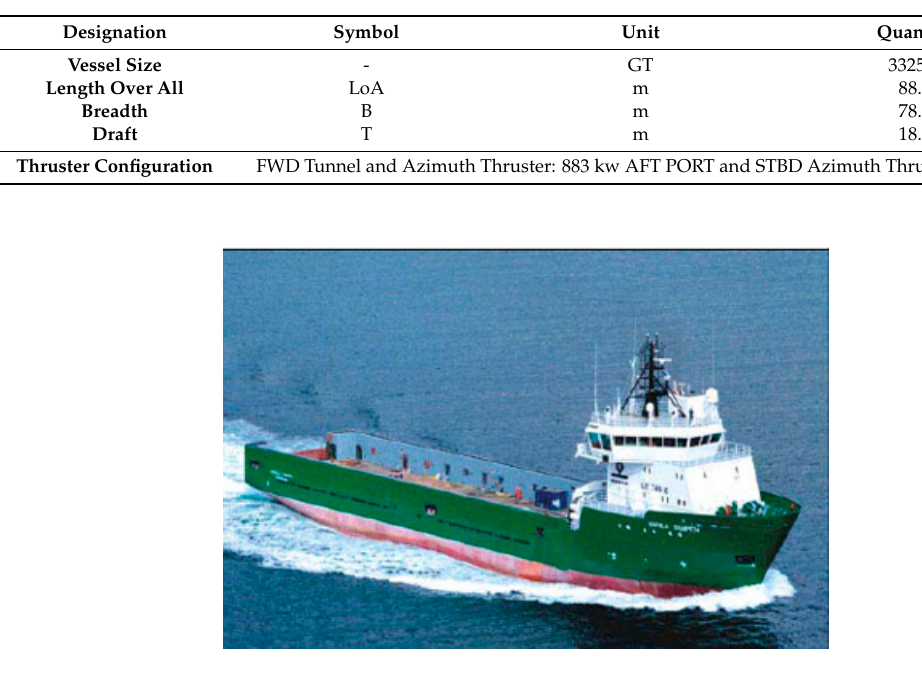
Table 2. Principal Dimension of Simulation Vessel.